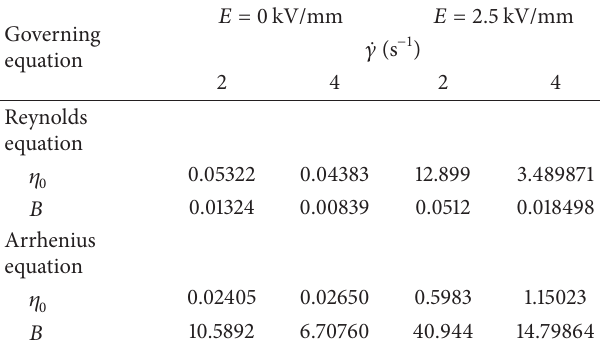
Table 3: Constants 𝜂 0 and 𝐵 .